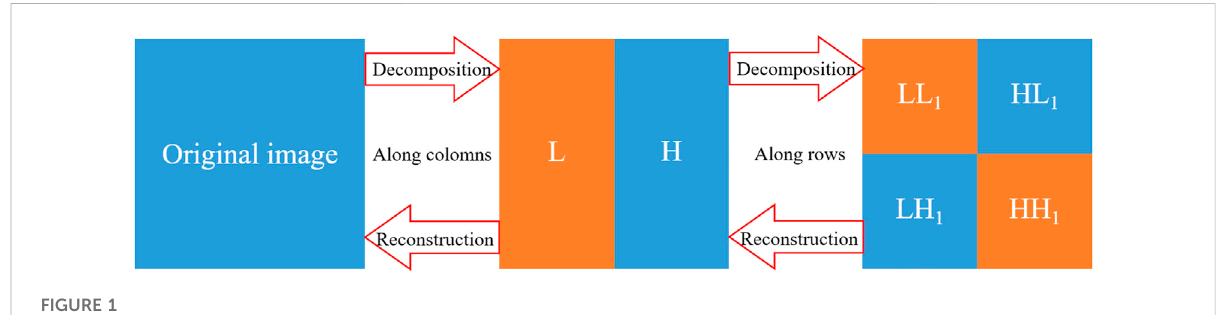
FIGURE 1 Discrete wavelet decomposition and reconstruction of